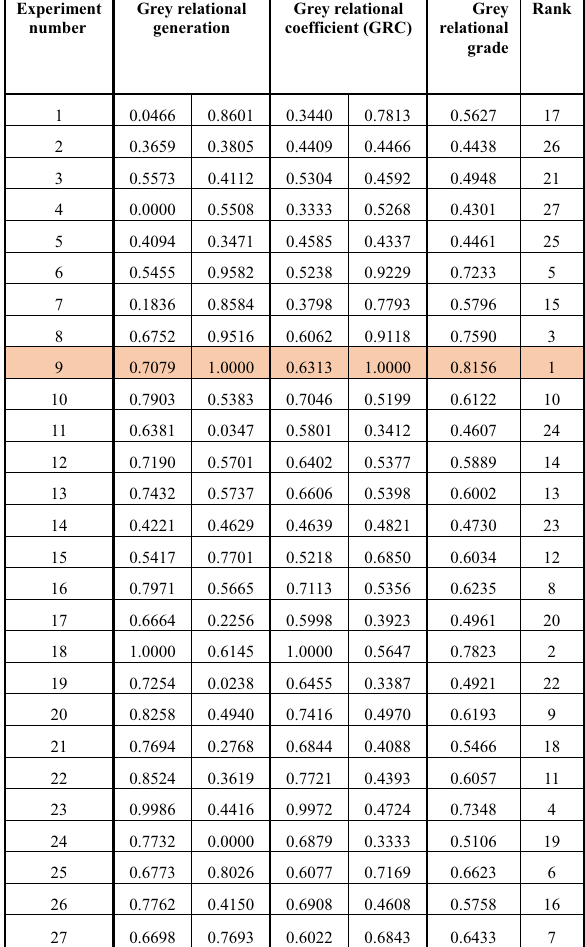
Table 4 Results of grey relational analysis Experiment